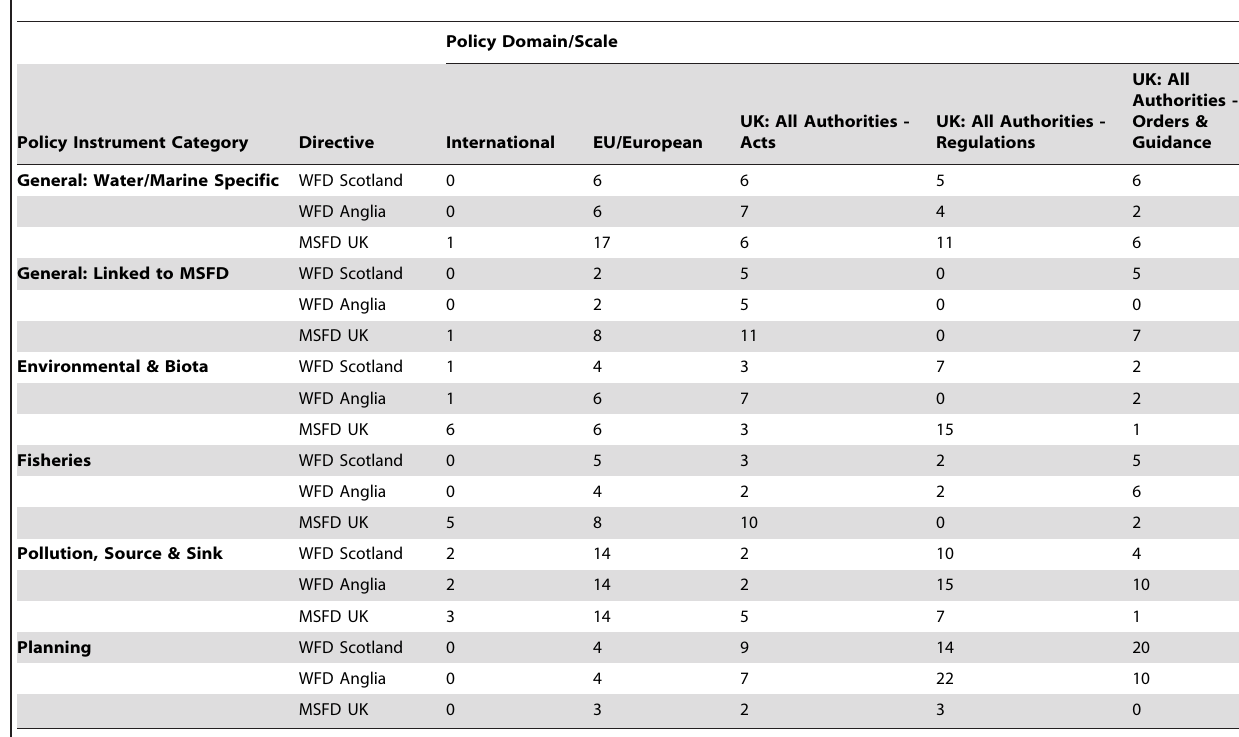
Table 4. Summary results for the policy instruments for the three case